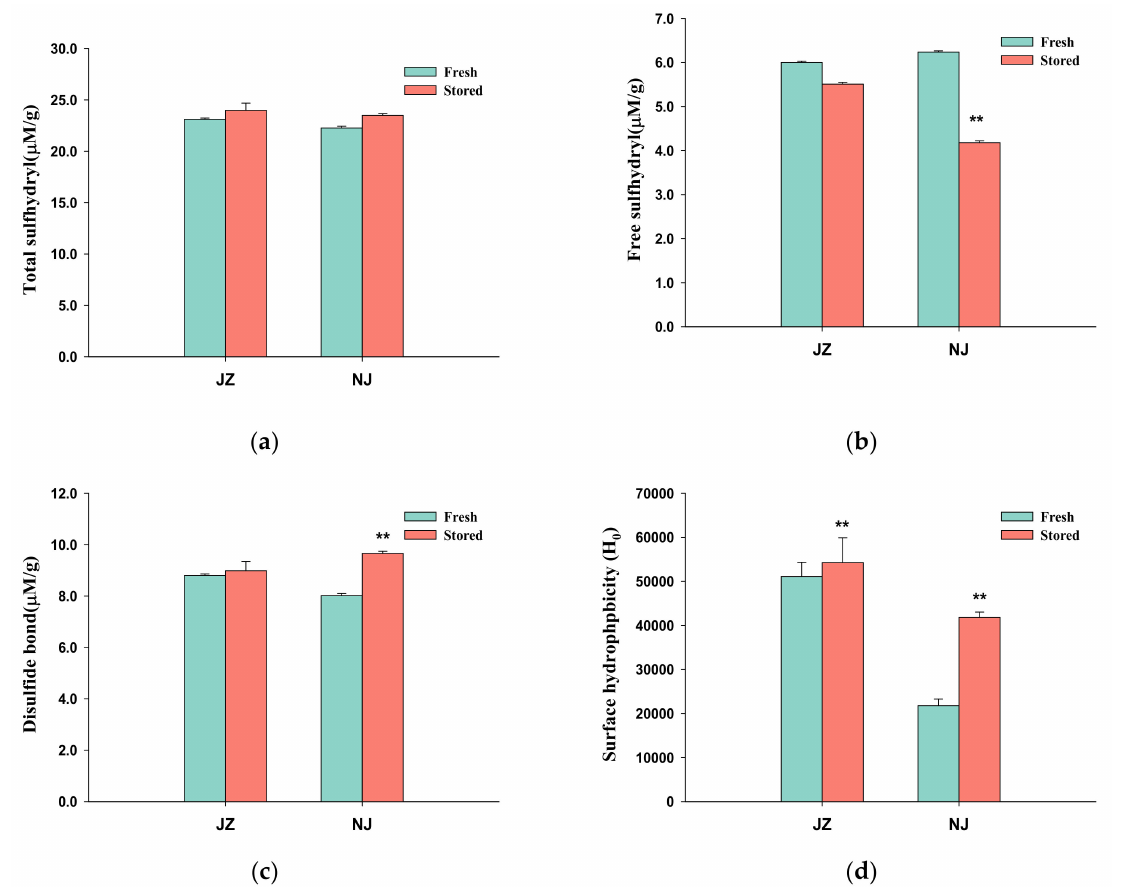
Figure 1. Effect of storage on the protein structural properties in rice. ( a ) Free sulfhydryl; ( b ) Total sulfhydryl; ( c ) Disulfide bonds; ( d ) Surface hydrophobicity H 0 . ( n = 3, **: α =